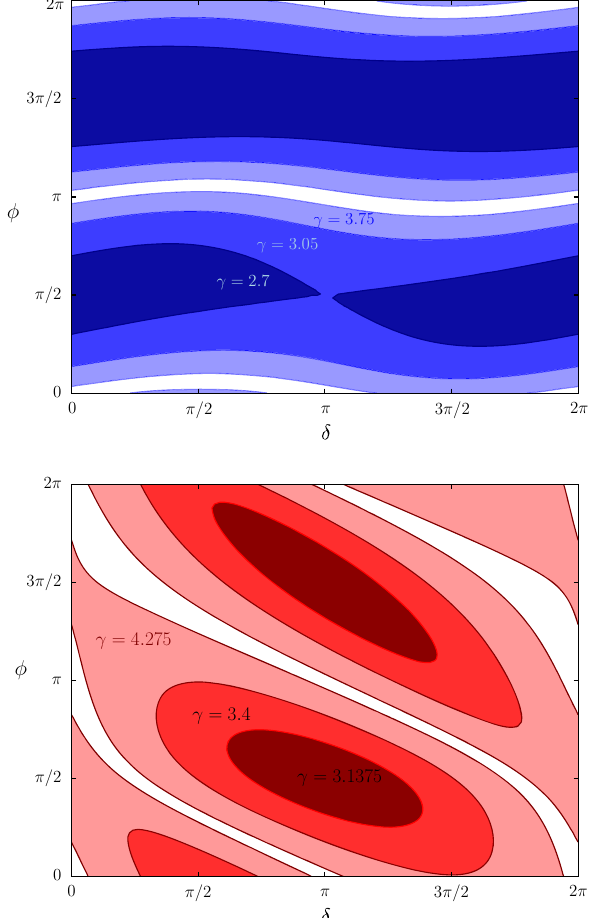
Fig. 5 5 σ CP violation SHiP discovery regions on the plane (δ,φ 1 ) for various true values of γ for IH ( up ) and NH ( down ) and for the true parameters M 1 = 1 GeV and θ =